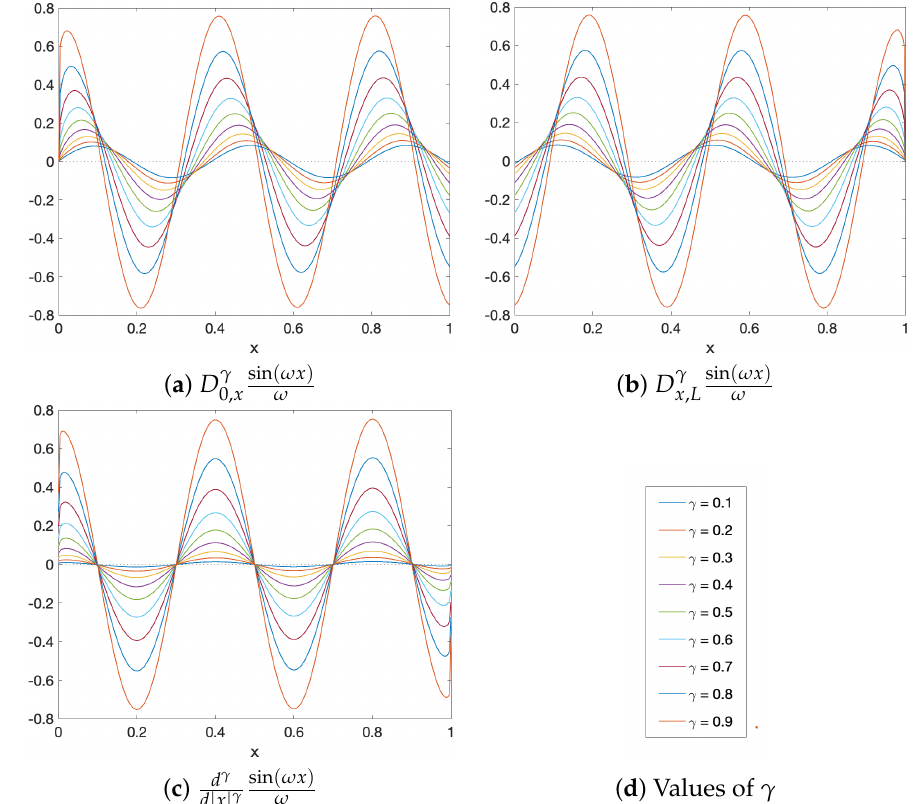
Figure 5. Example 3. The rescaled left (panel ( a )) and right (panel ( b )) Caputo derivatives and the Riesz–Caputo derivative (panel ( c )) of the function y ( x ) = sin ( ω x ) , for different values. of γ (panel ( d )) with ω = 5 π .